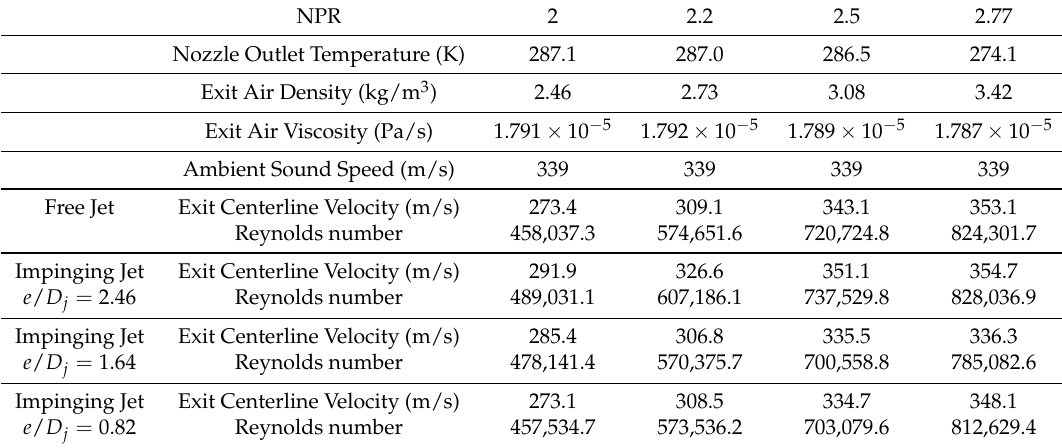
Table 1. Physical exit flow conditions for under-expanded free jets and impinging jets at various nozzle-to-plate gaps and various values of